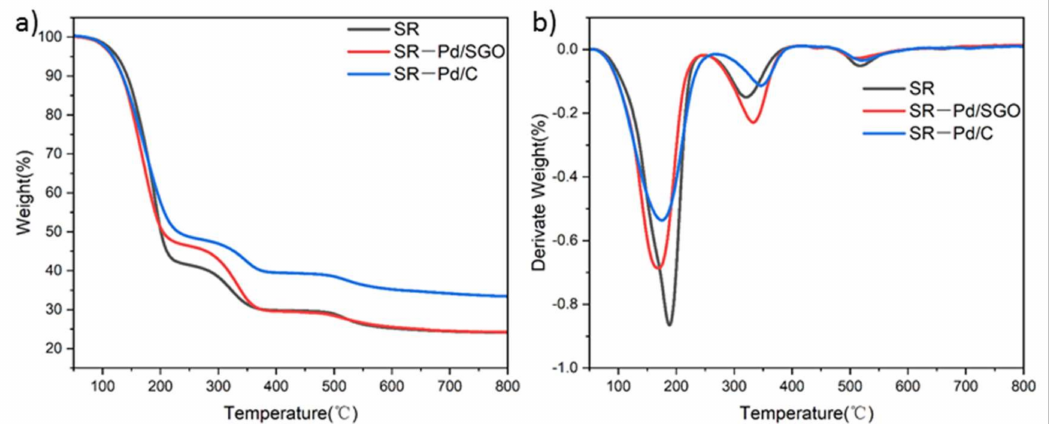
Figure 12. TG ( a ) and DTG ( b ) curves of pure SR, SR-Pd/SGO and SR-Pd/C composites.